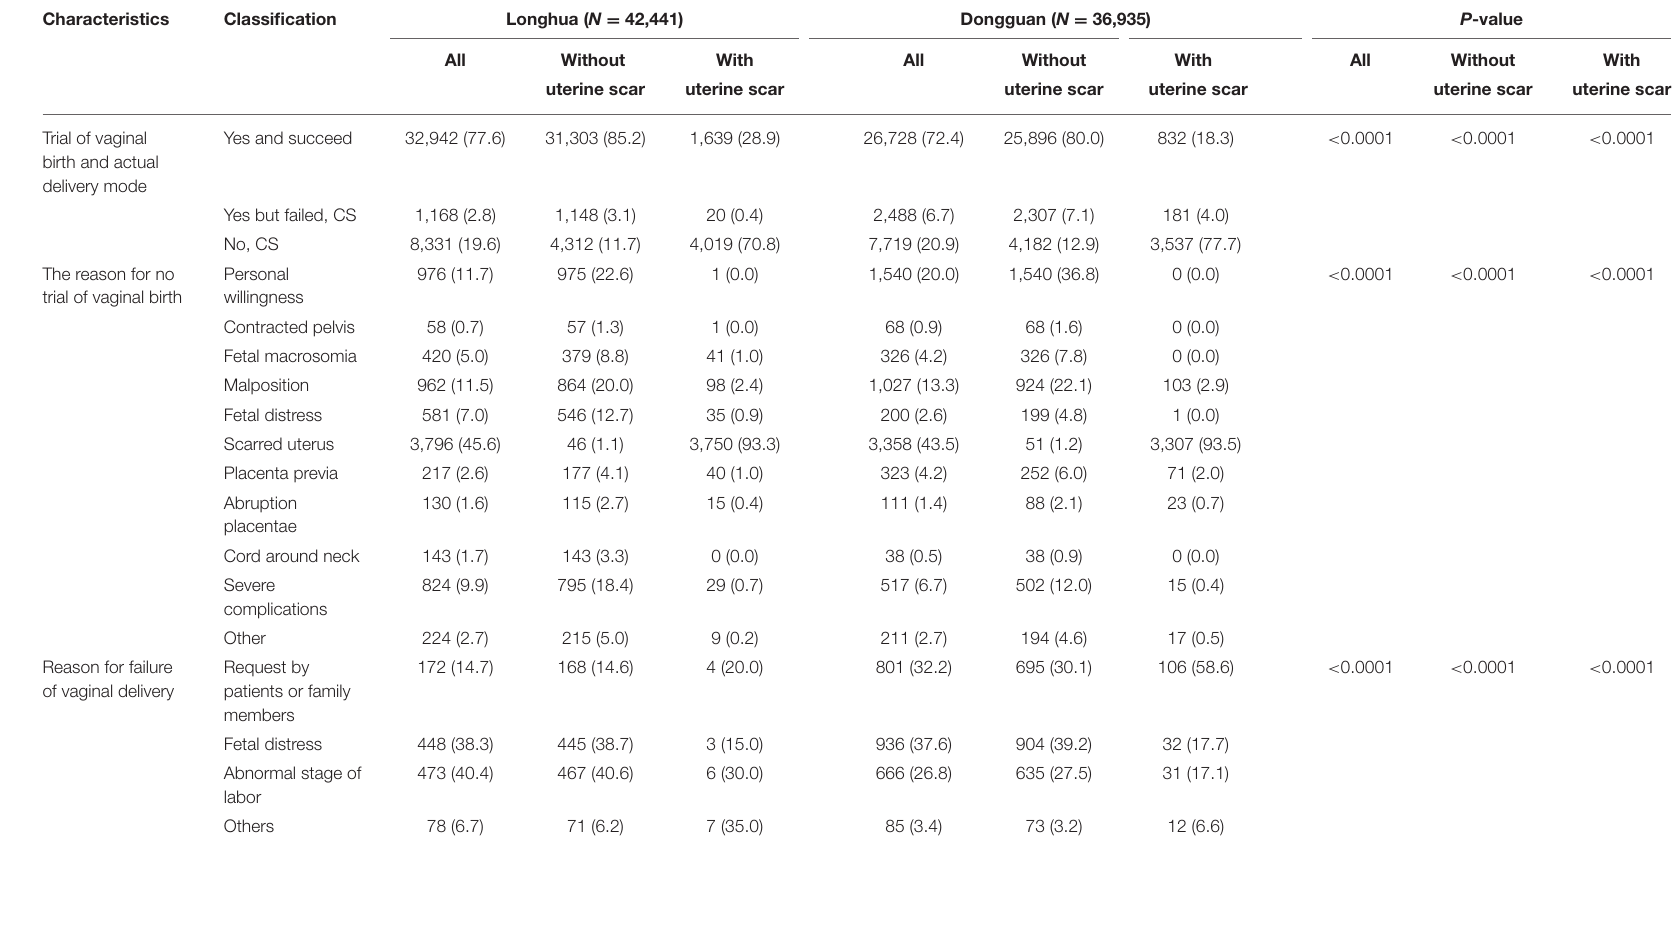
TABLE 4 | Vaginal birth trial and reasons for no trial and trial failure in two hospitals in Guangdong, China. Characteristics